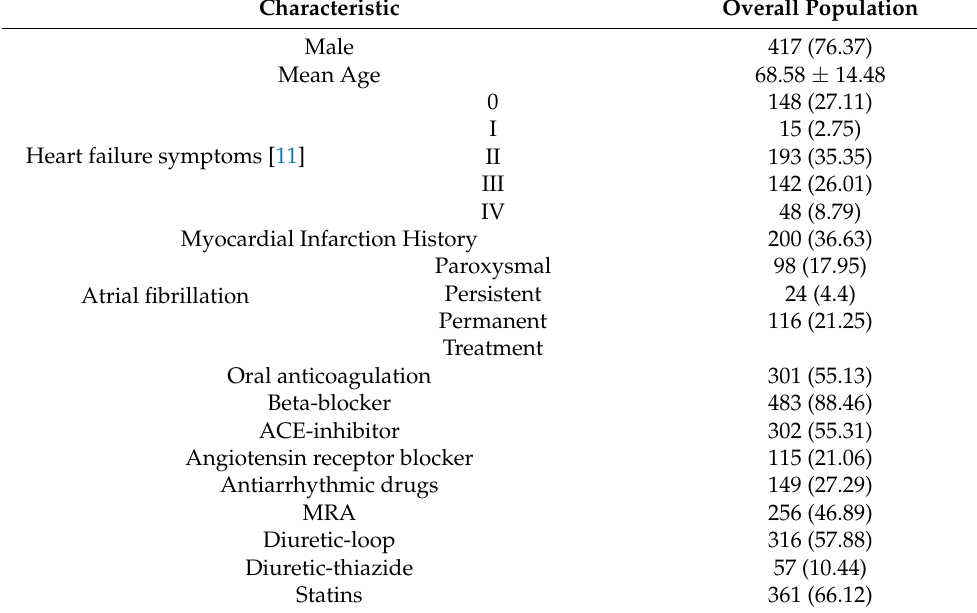
Table 1. Patient